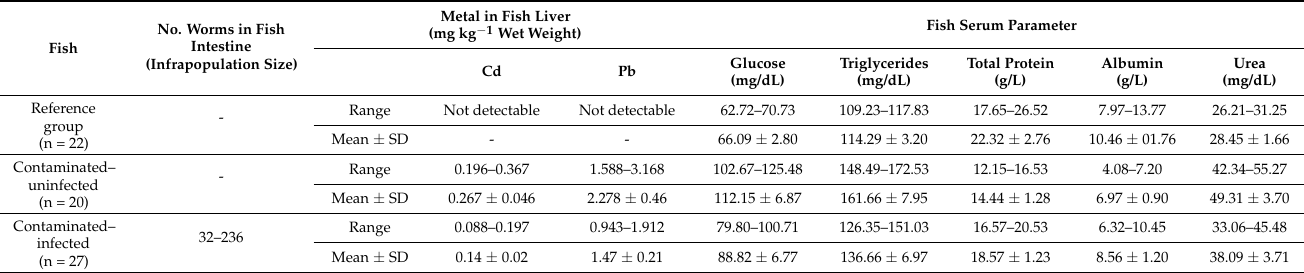
Table 3. Cd and Pb concentrations and levels of serum glucose, albumin, total protein STP, and triglycerides in the reference group, in the contaminated–uninfected, and in the contaminated–infected individuals of the fish Siganus rivulatus . No. WormsinFish Fish